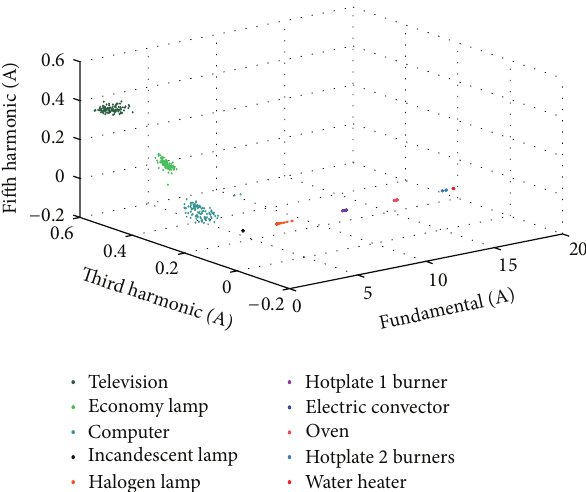
Figure 9: The feature space showing the disaggregated contribution of the fundamental and harmonic currents to the maximum of the total current for several appliances.